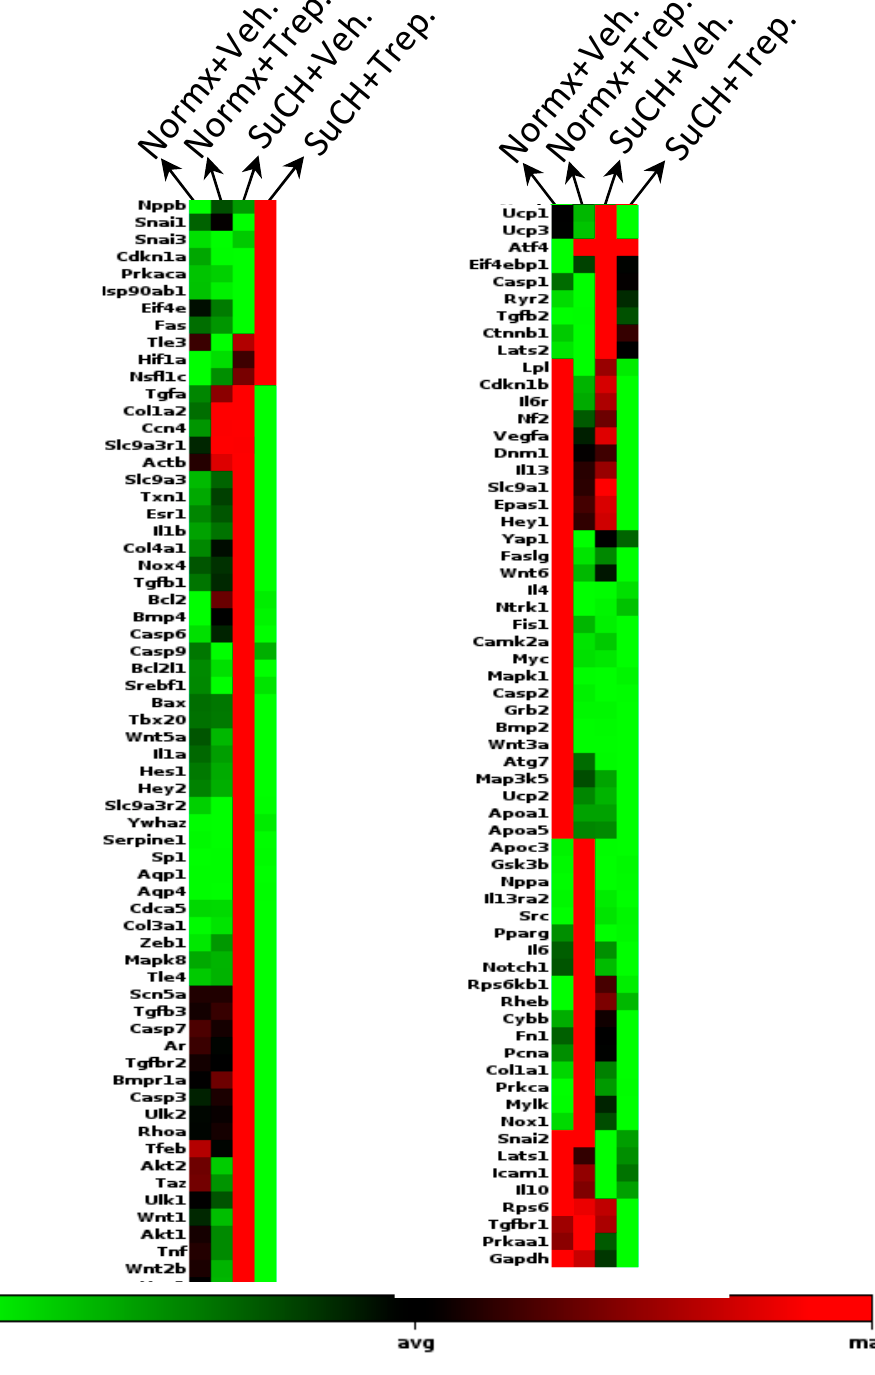
Figure 5. Clustergram of genes affected by SuCH and treprostinil treatment. Heat map of gene expression changes in normoxia+vehicle. (normx+Veh.), normoxia+treprostinil (normx+Trep.), SuCH+vehicle (SuCH+Veh.), and SuCH+treprostinil (SuCH+Trep.); n = 3 animals/experimental group; green and red represent the minimum and maximum gene expression, respectively, normal- ized to housekeeping gene HSP90.